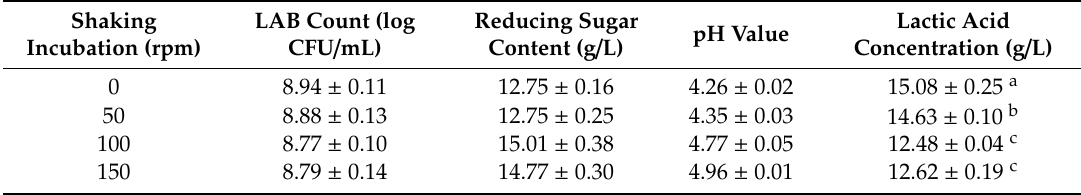
Table 5. The e ff ects of agitation on lactic acid